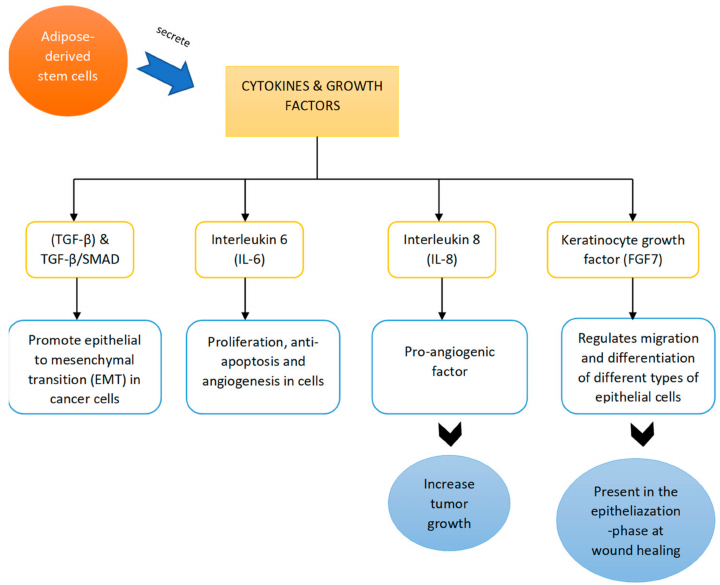
Figure 2. Proposed signaling pathways involved in the activation of ADSCs to induce tumor